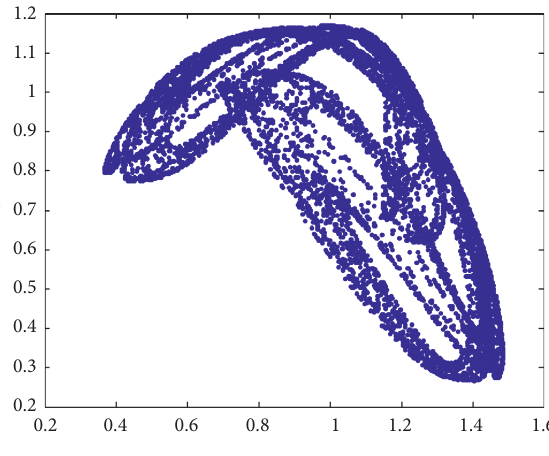
Figure 21: x - n sequence diagram which denotes that the system is 4-fold periodic when c �